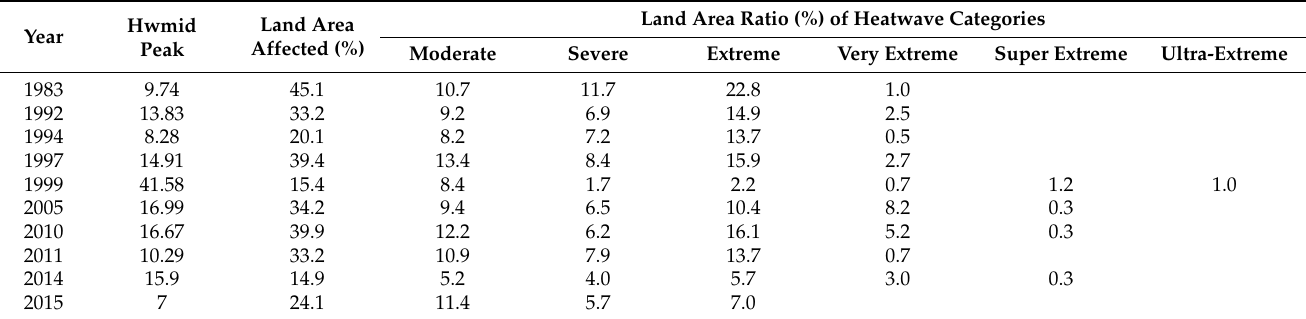
Table 3. The top most excessive heatwave events in the observed climate (1983–2016) averaged over Tanzania. Hwmid Year Peak